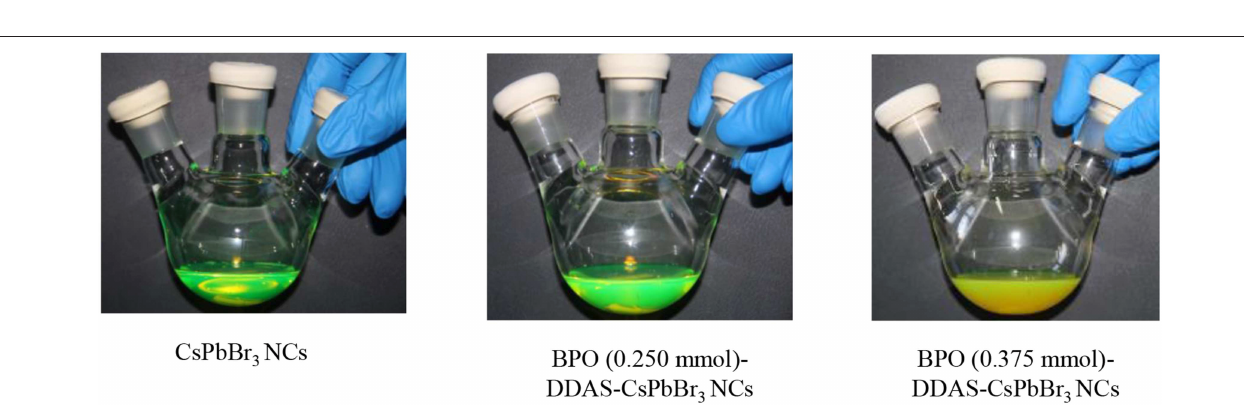
spacing of the CsPbBr 3 NCs, DDAS-CsPbBr 3 NCs, and BPO- DDAS-CsPbBr 3 NCs. As shown in Figure S6 , lattice spacing